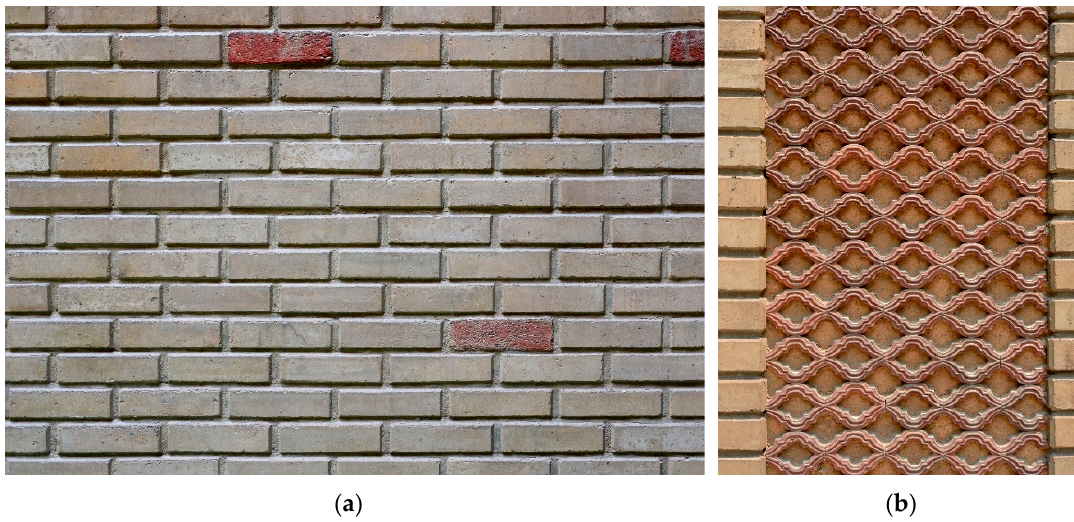
Figure 28. Figure 28. The material palette of the DA building consists of earthy materials such as ( a ) cement- stabilised compressed-earth blocks and ( b ) terracotta tiles (Photos: Author).